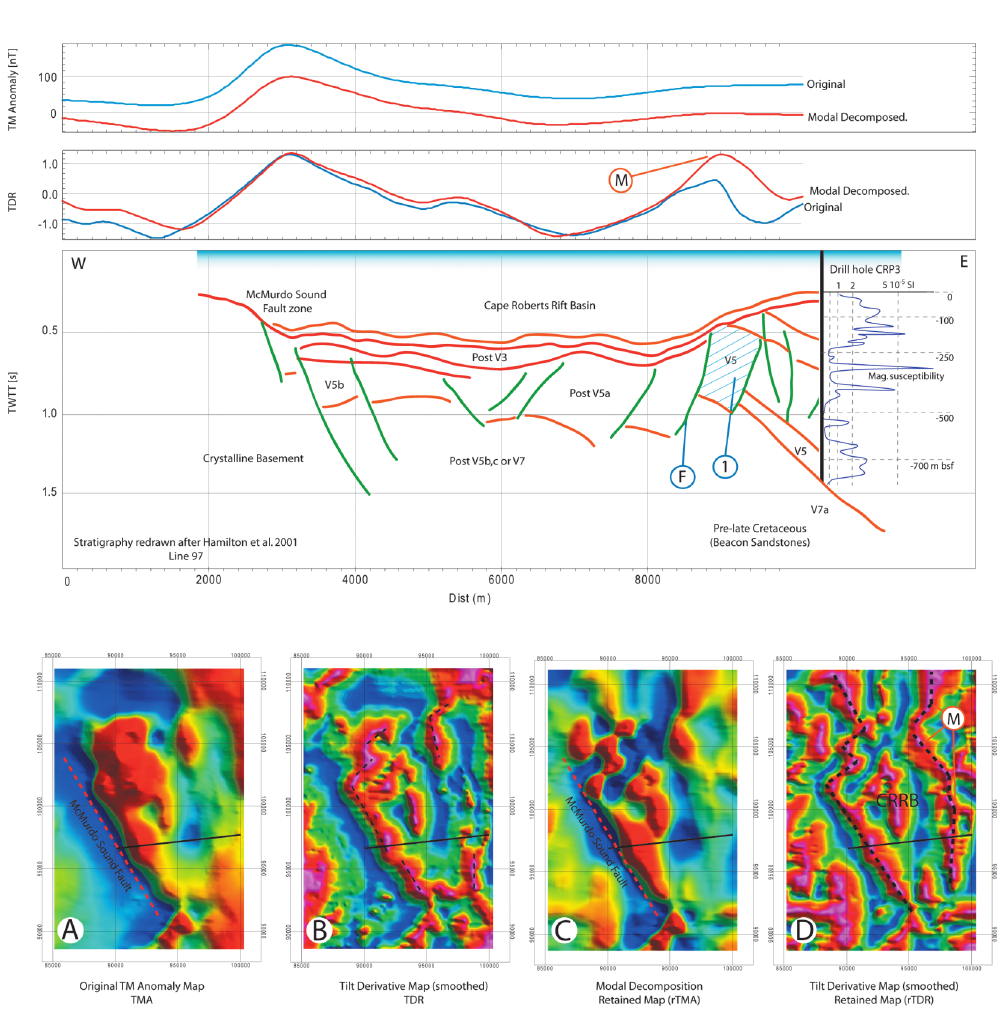
Fig. 4a-d. Modal decomposition CRRB HRAM. Above: TMI and tilt derivative profile data with a schematic geologic cross section (modified: Hamilton 2001). Below: a) Original TMI anomaly, b) Tilt derivatives calculat- ed using the original data, c) Modal decomposition – «retained map» (rTMA), d) Tilt derivatives calculated us- ing the «retained» dataset